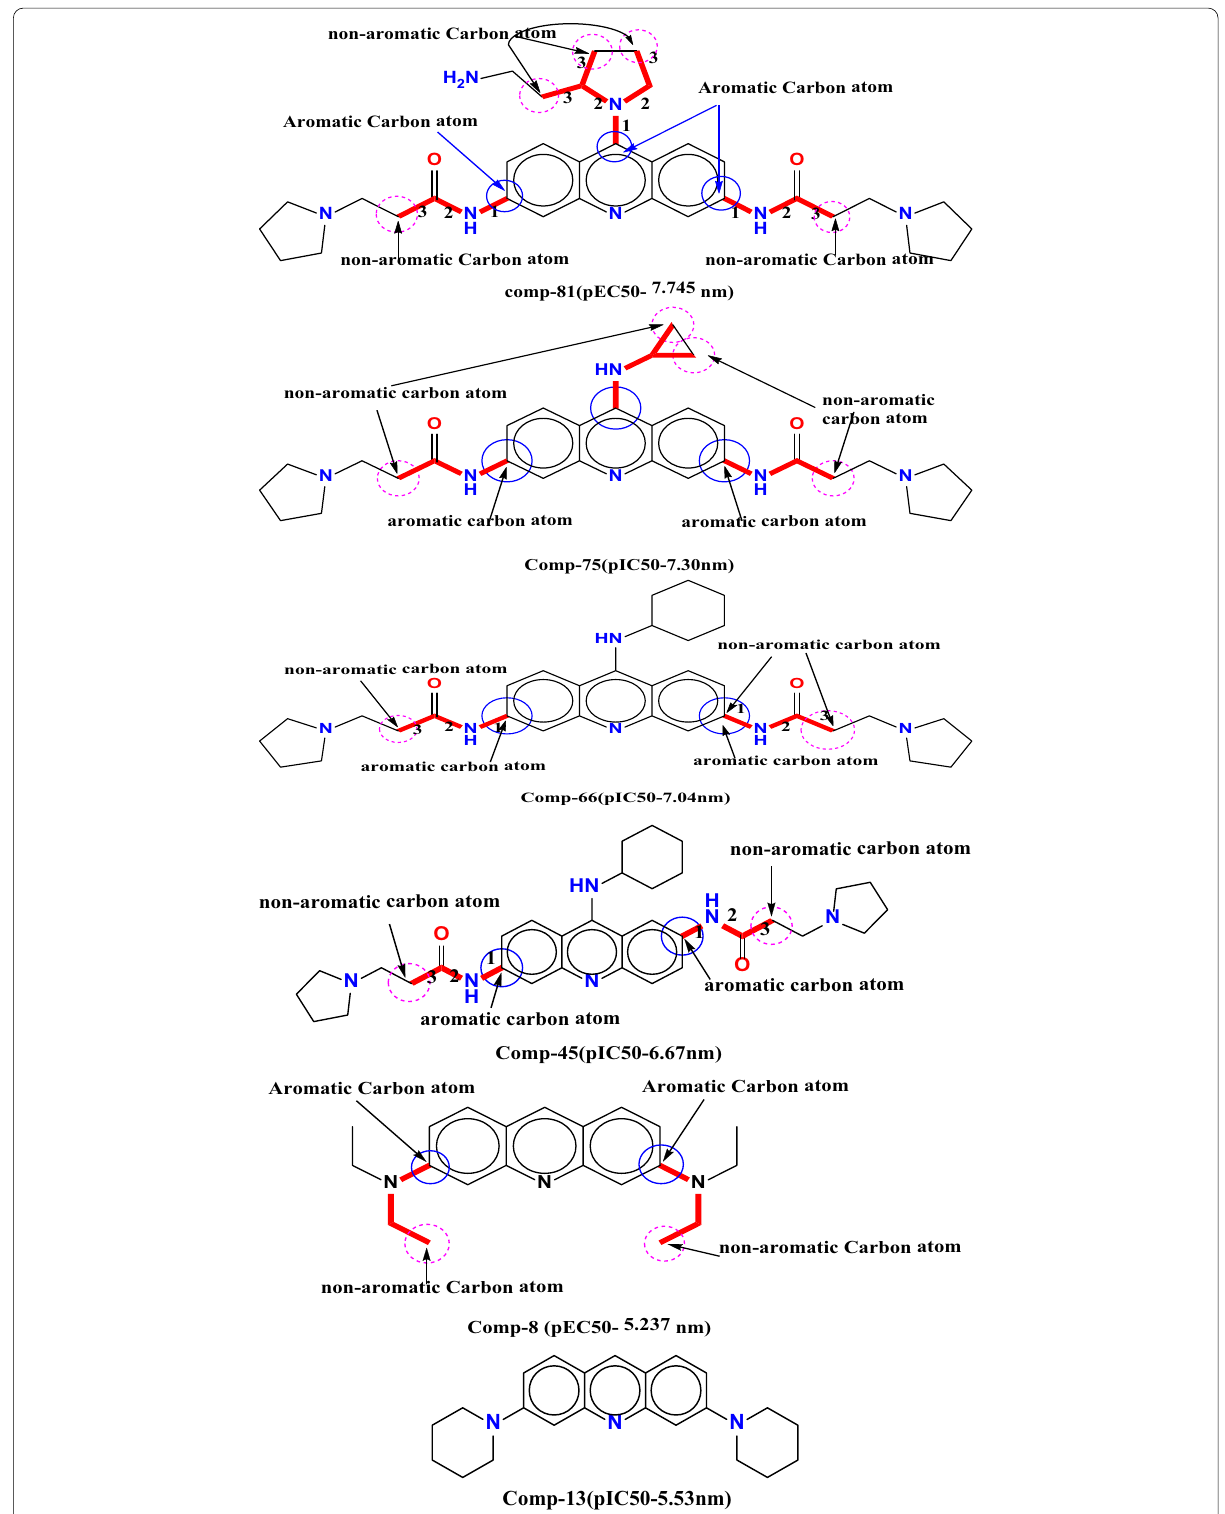
Fig. 6 2D pictorial depiction of faroCC3B descriptor for the compounds 81, 8, 13, 45, 66 and